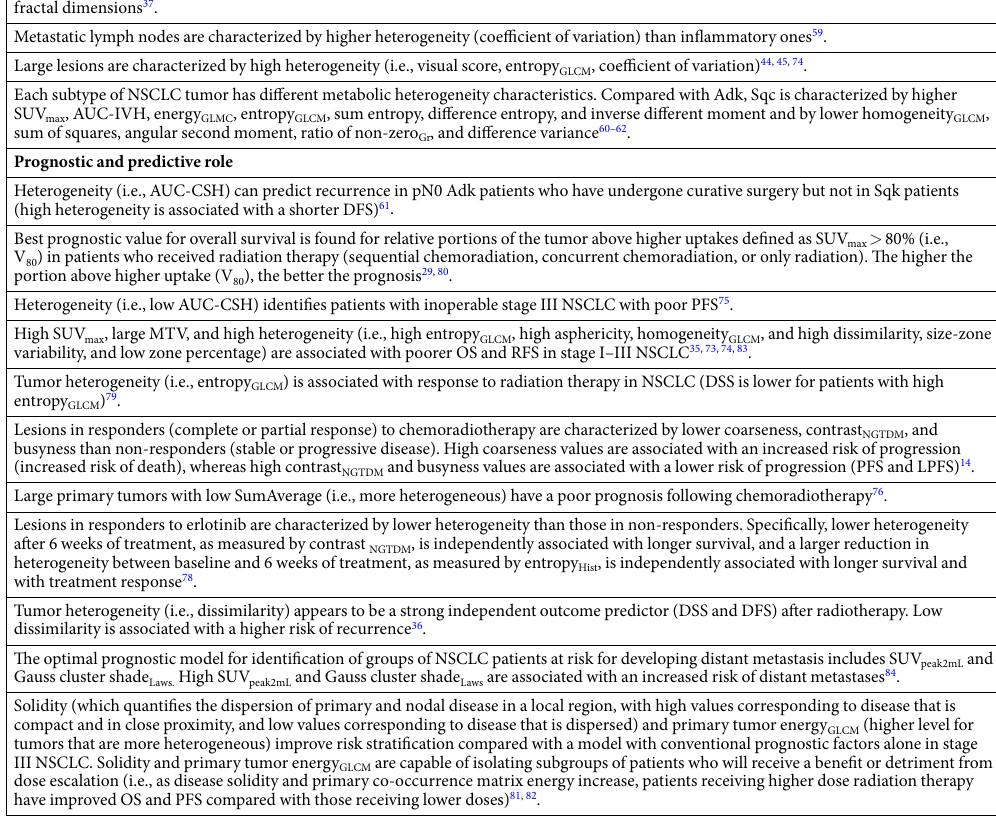
Table 3. Summary of clinically relevant results in investigations assessing the diagnostic, prognostic and predictive role of FDG-PET/CT texture analysis. Adk: adenocarcinoma type; AUC-IVH: area under the curve within the intensity volume histogram; DFS: disease-free survival; DSS: disease-specific survival; GLCM: gray-level co-occurrence matrix; GLRLM: gray-level run-length matrix; GLSZM: gray-level size-zone matrix; Gr: absolute gradient; LPFS: local progression-free survival; MTV: metabolic tumor volume; NGTDM: neighborhood gray-tone difference matrix; NSCLC: non-small cell lung cancer; OS: overall survival; PFS: progression-free survival; Sqc: squamocellular types; SUV: standardized uptake